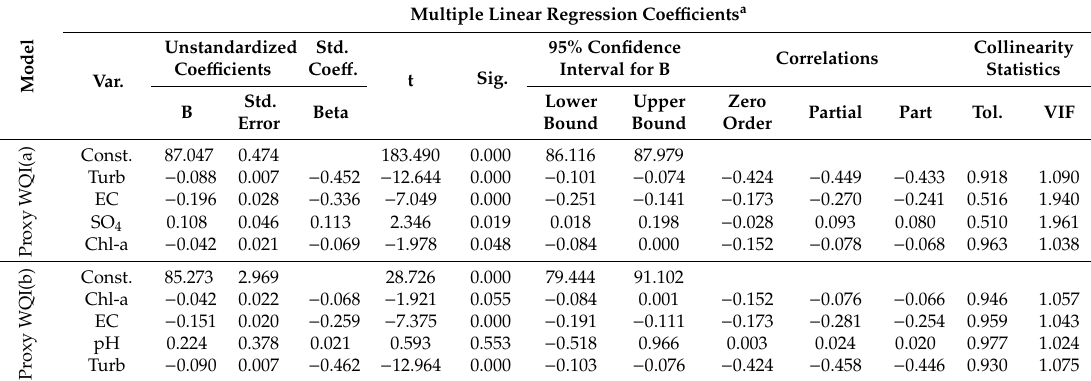
Table 6. Multiple Linear Regression (MLR) Coe ffi cients for Two Preliminary Surrogate Models, Proxy WQI(a) and Proxy